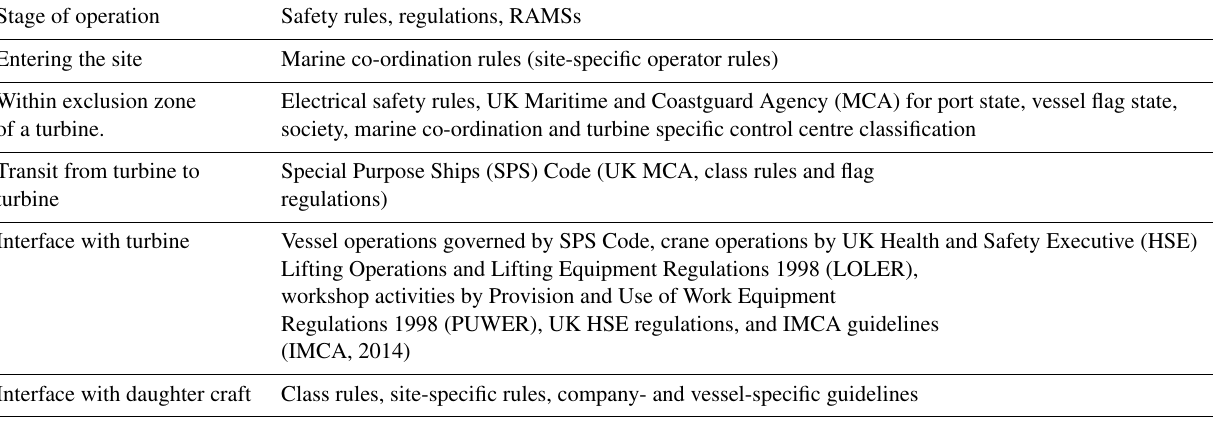
Table 1. Safety governance in various stages of operation. Stage of operation